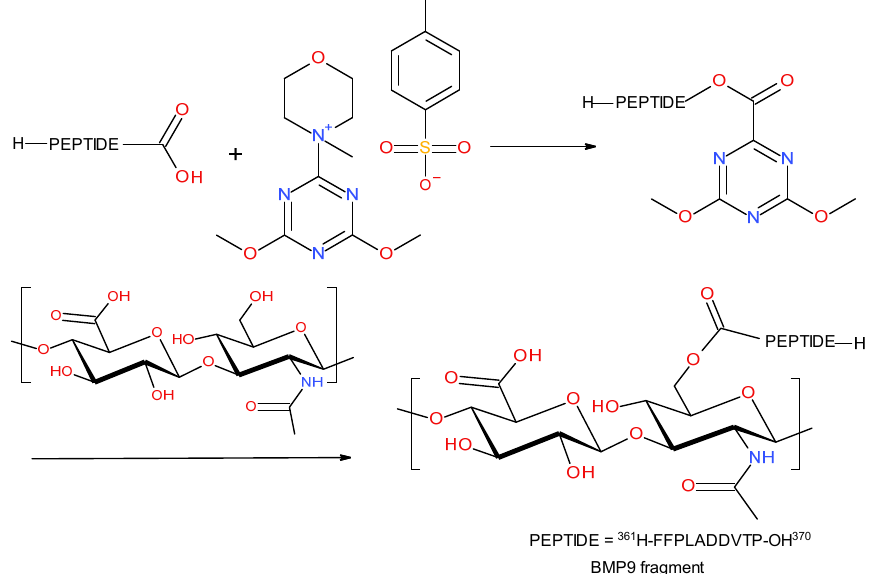
Figure 20. Schematic reaction of the polysaccharide–peptide condensation by using DMT/NMM/TsO - as the coupling reagent .